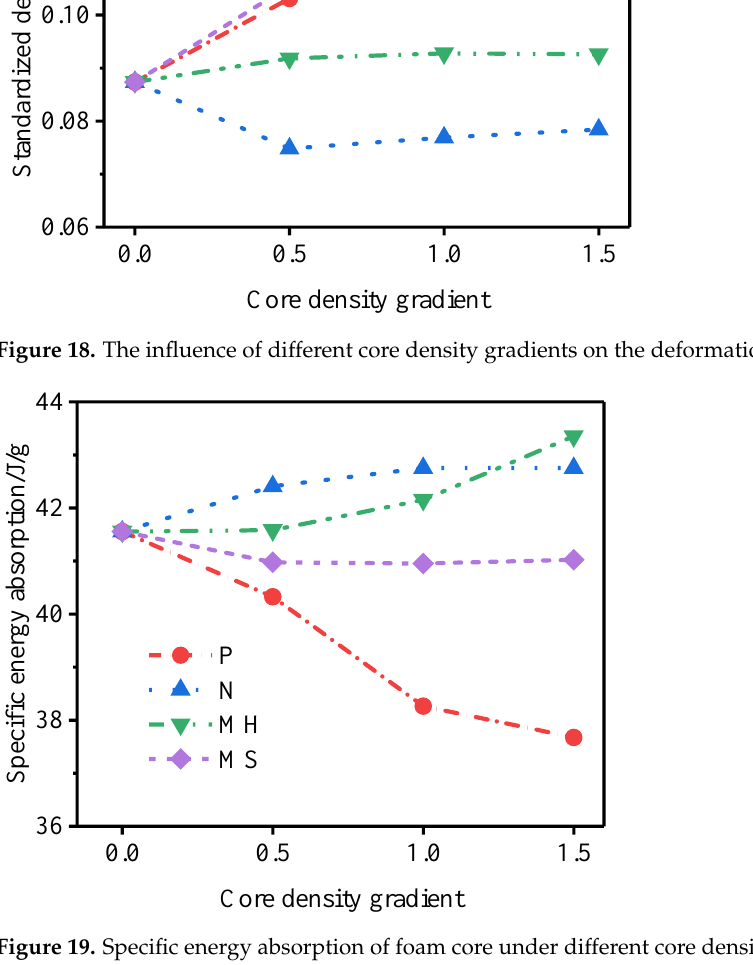
Figure 19. Specific energy absorption of foam core under different core density gradients.